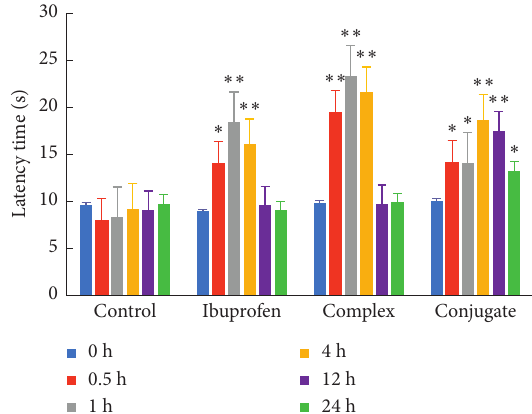
Figure 4: Effect of ibuprofen, complex, and conjugate on the response latency time in the hotplate tests in mice model ( n � 8). Each column represents the mean ± SEM. The asterisks denote the significance levels in comparison with the control group, ∗ P ＜ 0.05 and ∗∗ P ＜ 0.01.